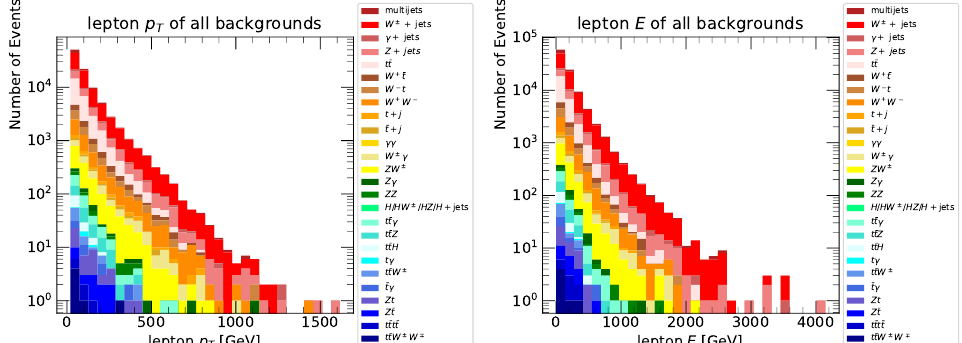
(left) and energy E (right) in GeV of the leptons T